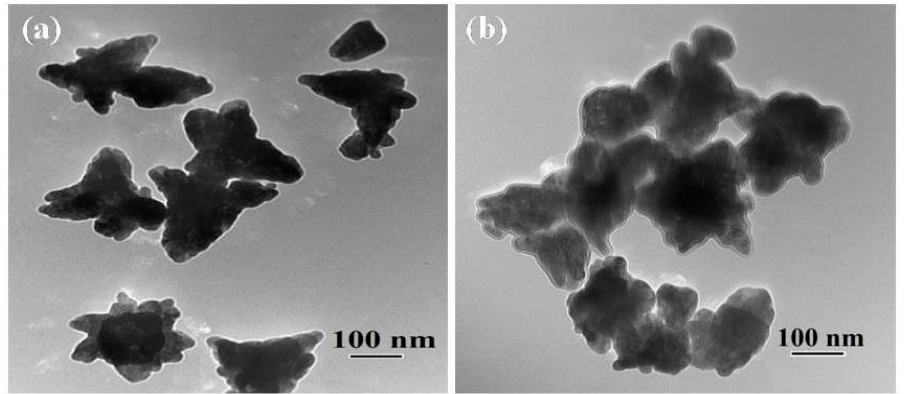
Figure 2. ( a , b ) Typical TEM images of pure ZnO nanoparticles. Figure 2. (a,b) Typical TEM images of pure ZnO